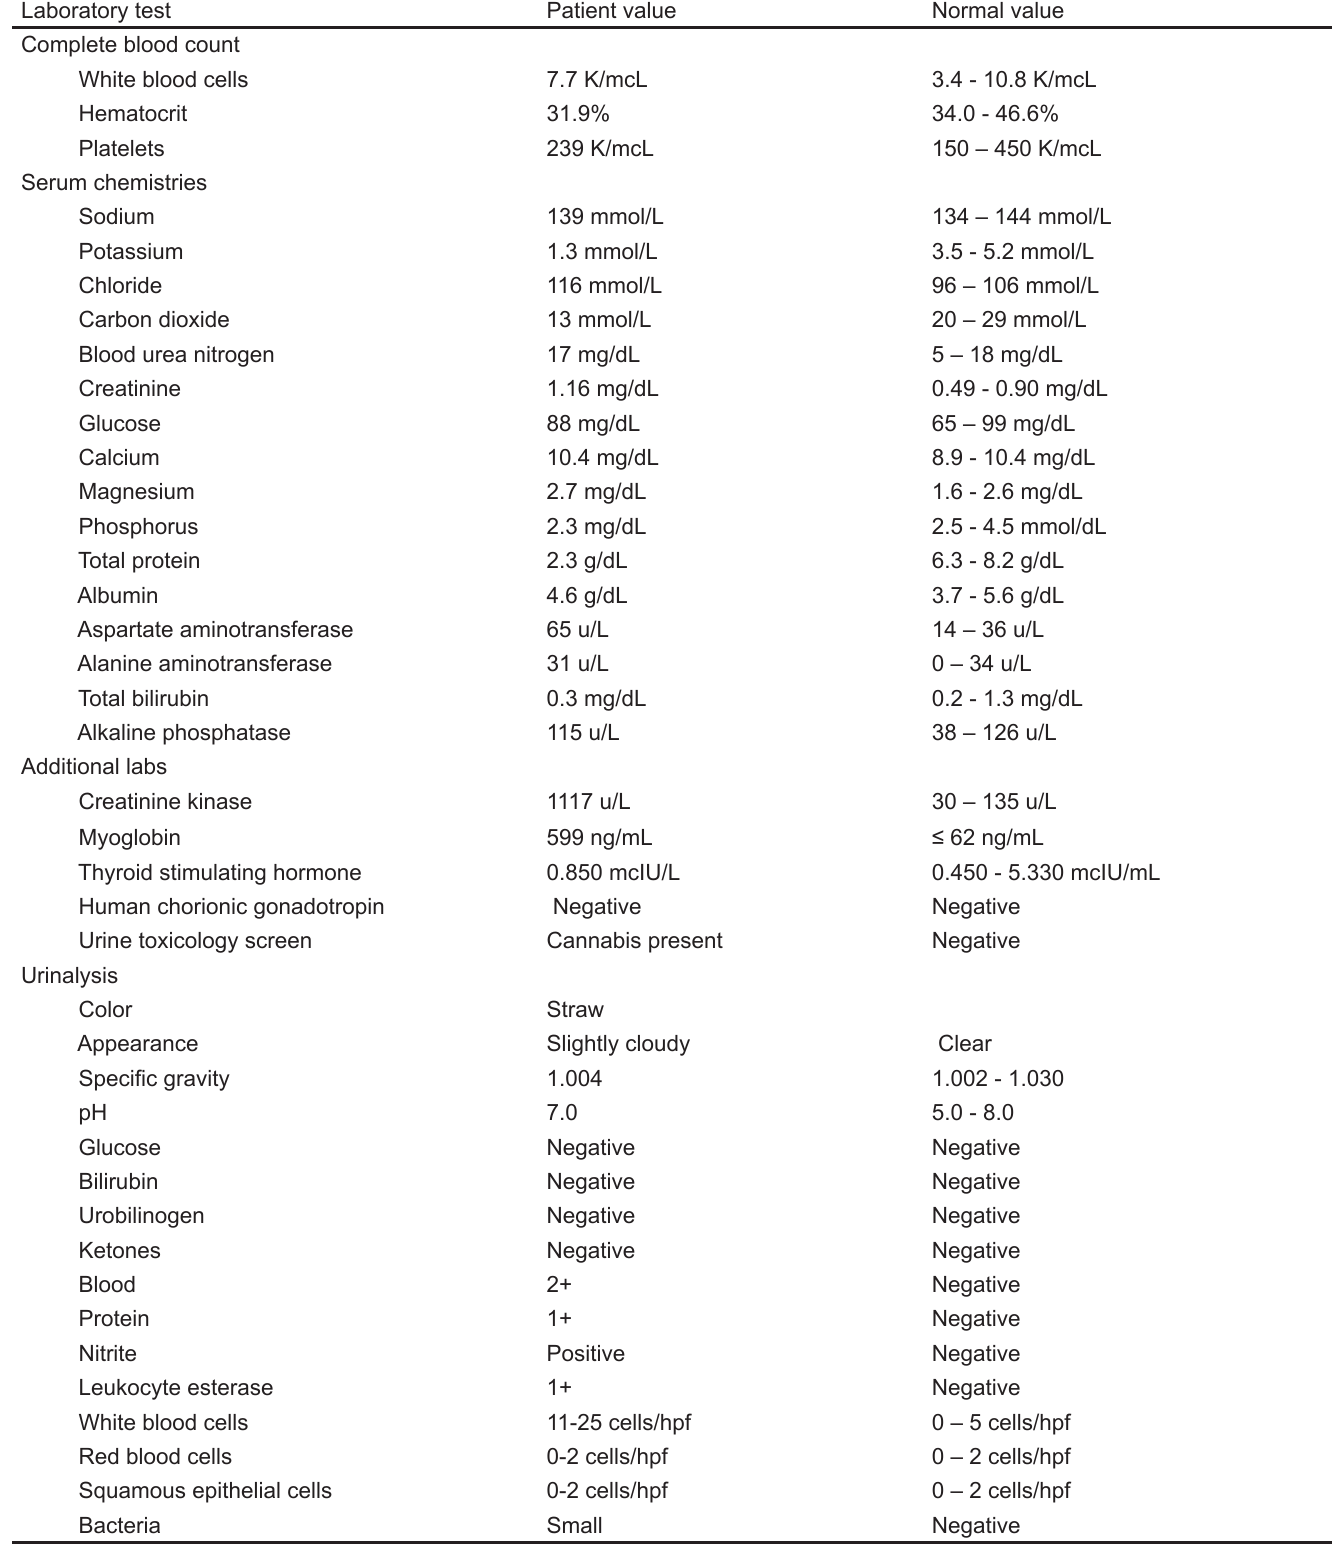
Table 1. Initial laboratory results of a 19-year-old female with